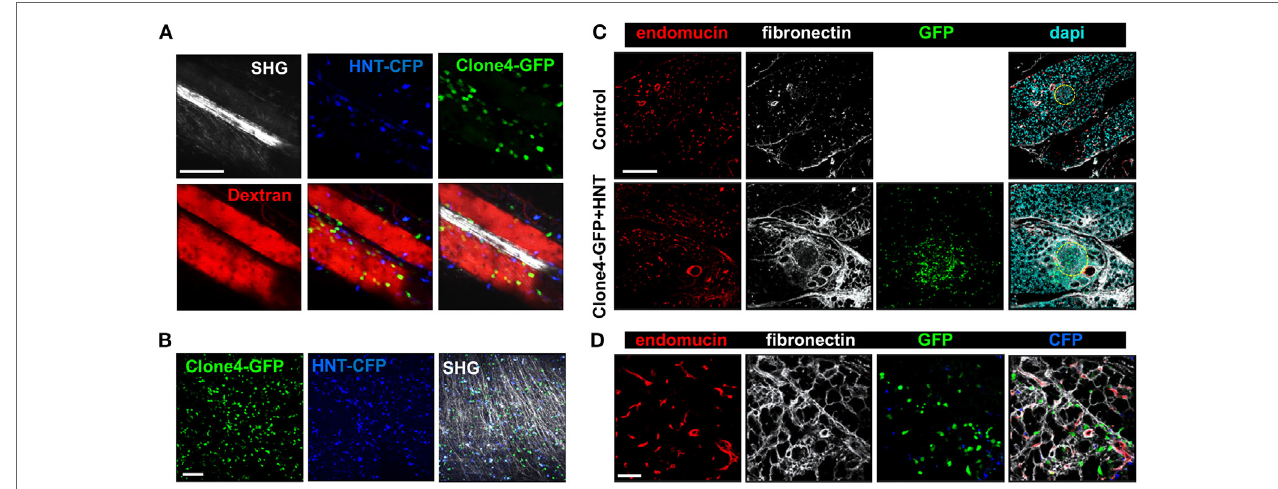
FigUre 4 | Effector T cells migrate along ECM fibers, which accumulate at infiltration sites. Irradiated InsHA-mCherry mice adoptively transferred with Clone 4-GFP CD8 + and HNT-CFP CD4 + T cells were subjected to intra-vital microscopy on day 8. (a) Still images from a movie at day 8 post transfer (scale: 100- and 87-µm Z -projection) (see also Videos S3 in Supplementary Material). SHG, second harmonic generation; red, rhodamine-dextran. (B) Still images from a movie at day 8 post transfer (scale: 100- and 100-µm Z -projection) (see also Videos S4 in Supplementary Material). SHG, second harmonic. (c) Representative confocal images of PA of a control irradiated InsHA-mCherry mouse, or post-transfer of T cells (scale: 200 µm, Z -projection of 20 µm). Islets are circled. (D) Representative confocal images of exocrine tissue at day 8 post transfer (scale: 50 µm, Z -projection of 4 µm), showing transferred T cells in close apposition to fibronectin